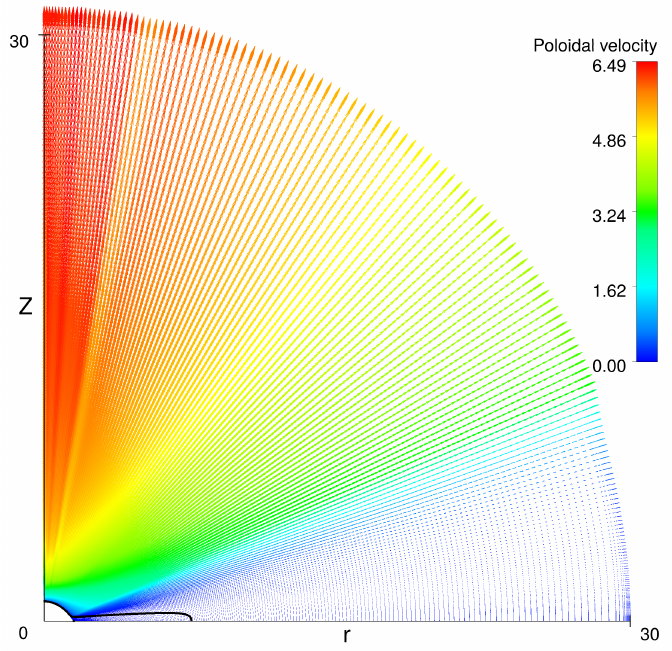
Figure 4. The field of velocity in the poloidal plane at ω = 1.005. Thick black solid line—sound line for the poloidal velocity.